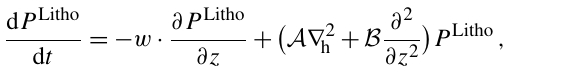
Figure 2. Dust deposition on a logarithmic scale (gm − 2 yr − 1 ). It is the integrated flux over the 12-month climatology based on Hauglustaine et al.